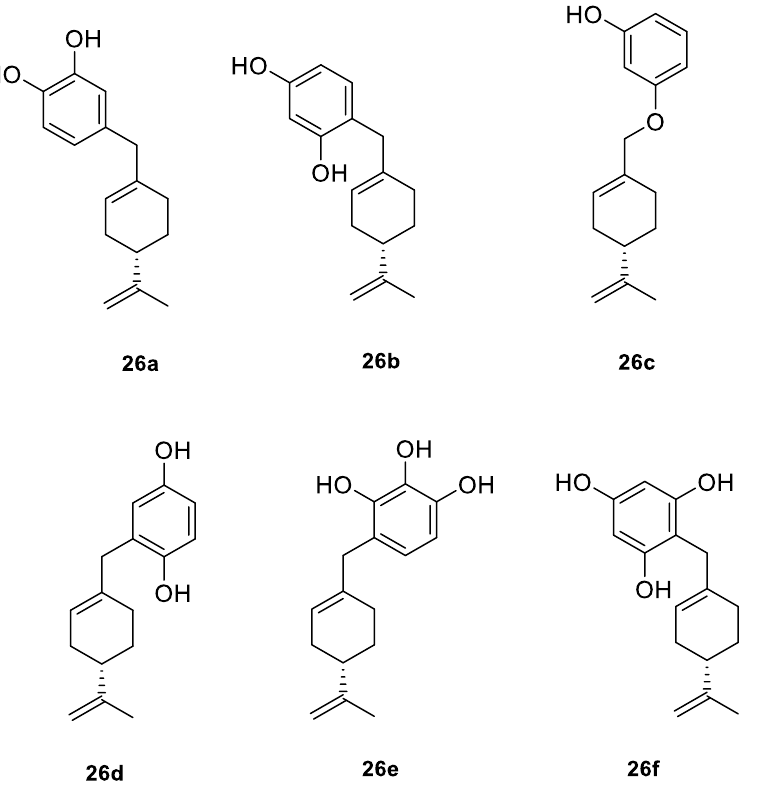
Figure 13. Selected cyclodiprenyl phenols derivatives.